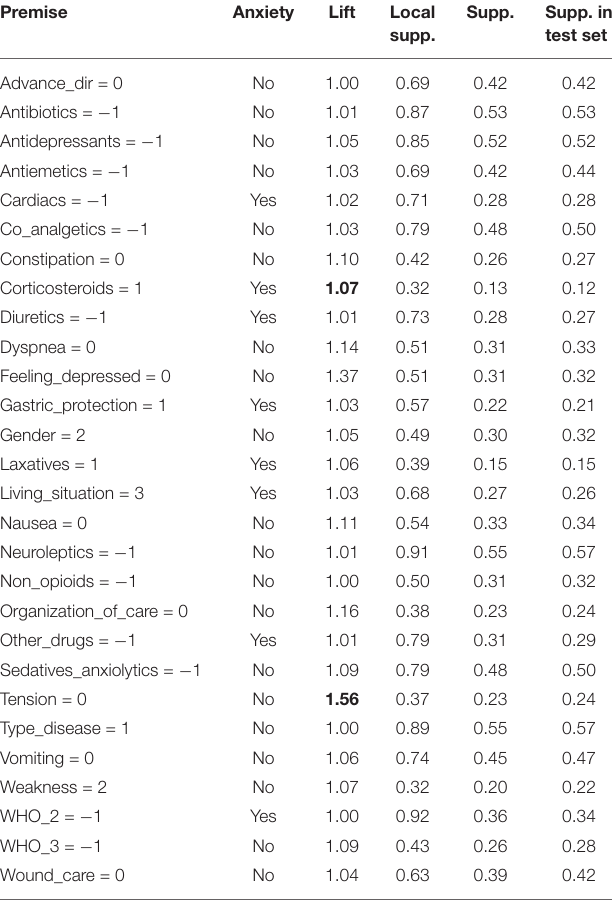
TABLE 4 | All the rules that apply to the record described in Table 3 . Premise Anxiety Lift Local